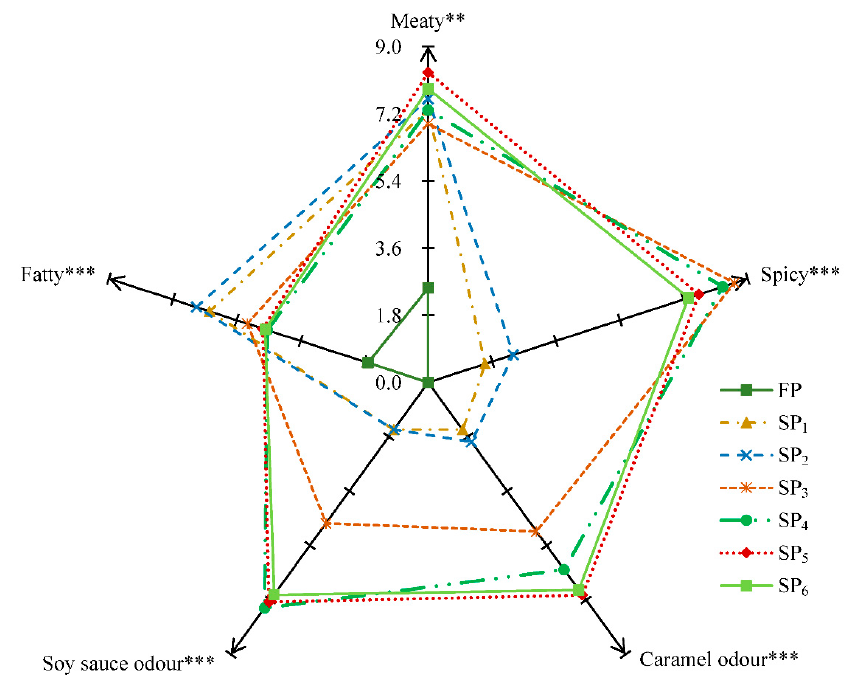
Figure 4. The odour sensory profiles of the fresh and stewed pork. Asterisks indicate significant